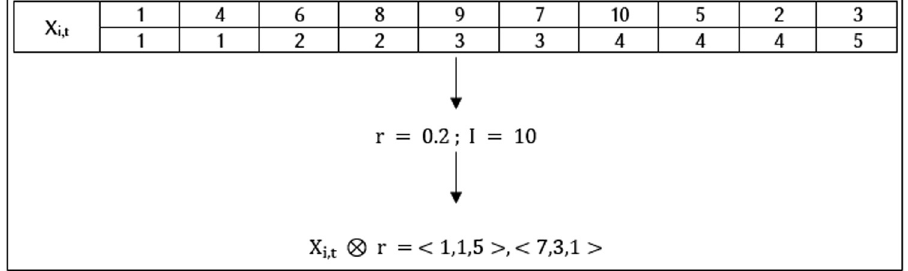
Figure 3: An example of using ⊗ X r i t , .